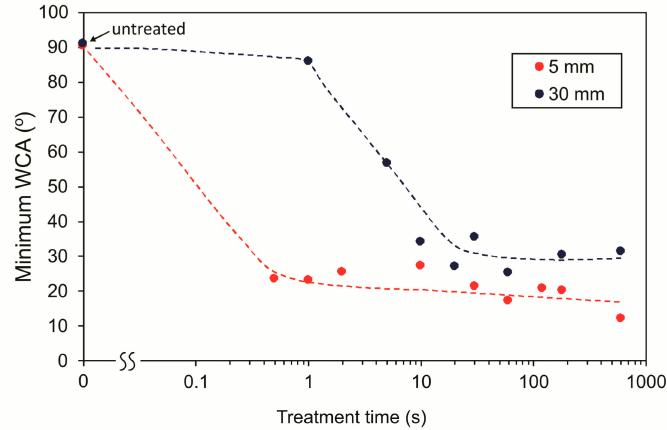
Figure 11. The minimum apparent water contact angle of polystyrene samples exposed to APPJ at distances of 5 and 30 mm versus treatment time.